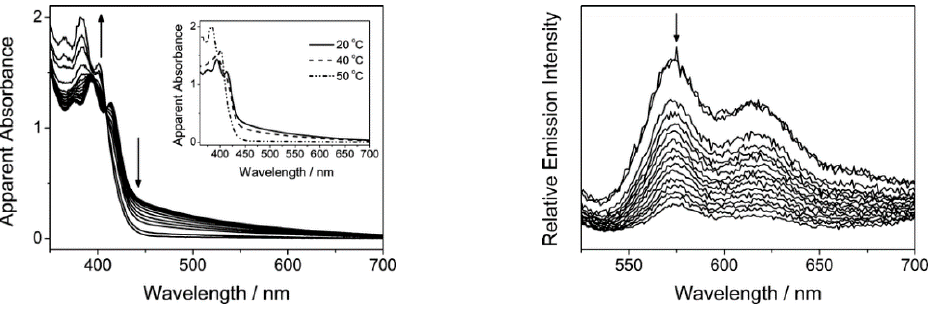
Figure 5. Ultraviolet (UV)-vis absorption spectral traces of the sol-gel phase transition of Complex 4 in hexane upon an increase in the temperature from 10 °C to 50 °C. Inset: Spectral traces at 20 °C, 40 °C, and 50 °C ( left ); Corrected emission spectra of the hexane gel of Complex 7 upon an increase in the temperature from 10 °C to 40 °C ( right ). Adapted with permission from ref. [1]. Copyright 2013 American Chemical